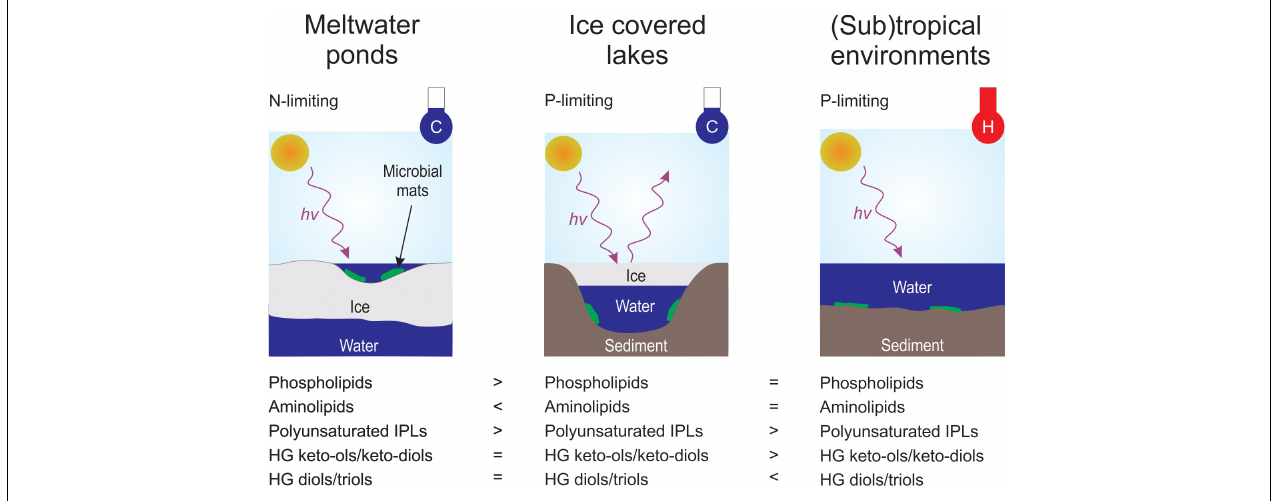
FIGURE 8 | Conceptual sketch of the presenting controlling environmental parameters and the corresponding lipid membrane signatures. Environmental parameters include light regime (hv + ), temperature in cold (C; blue thermometer) and warm (H; red thermometer), ice coverage and nutrient (N-limiting or P-limiting)